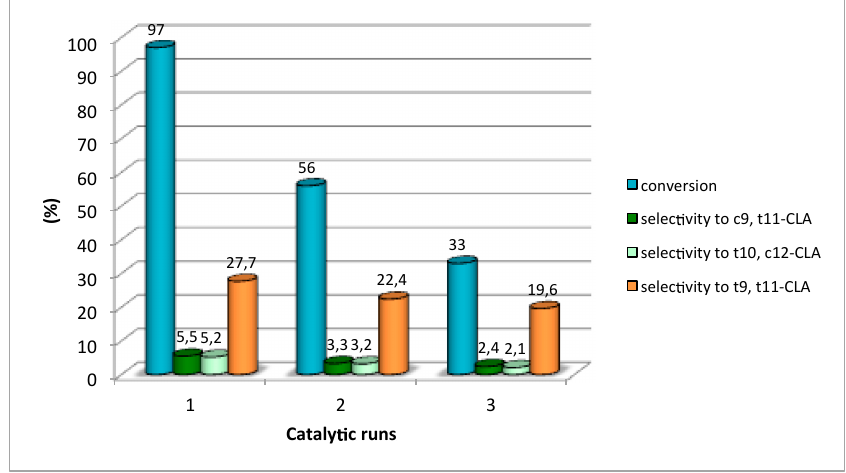
Figure 7. Catalytic life of catalyst HTMgAl3. 318